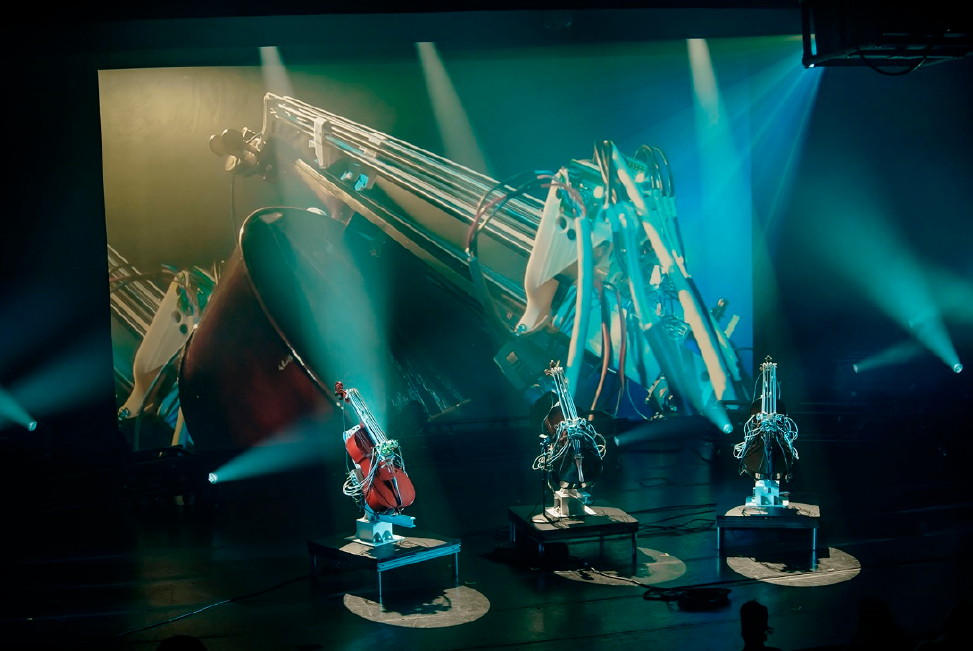
Figure 3. Robot-controlled cellos in Empty Vessels (2022) by Montreal Life Support and Woulg. Courtesy of the artists. Photo credit: Myriam Ménard.